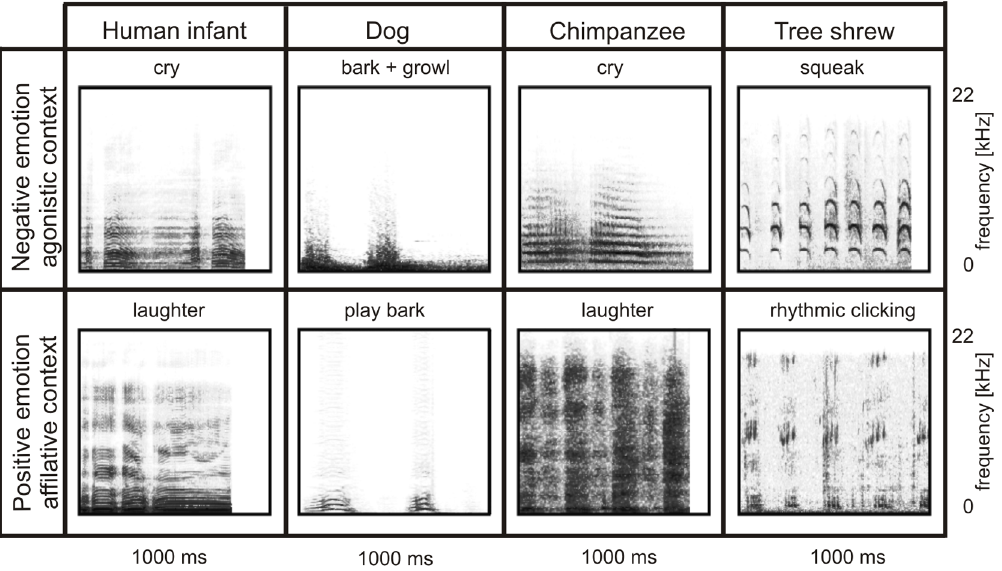
Figure 1. Sonograms of examples of playback stimuli of the eight playback categories.